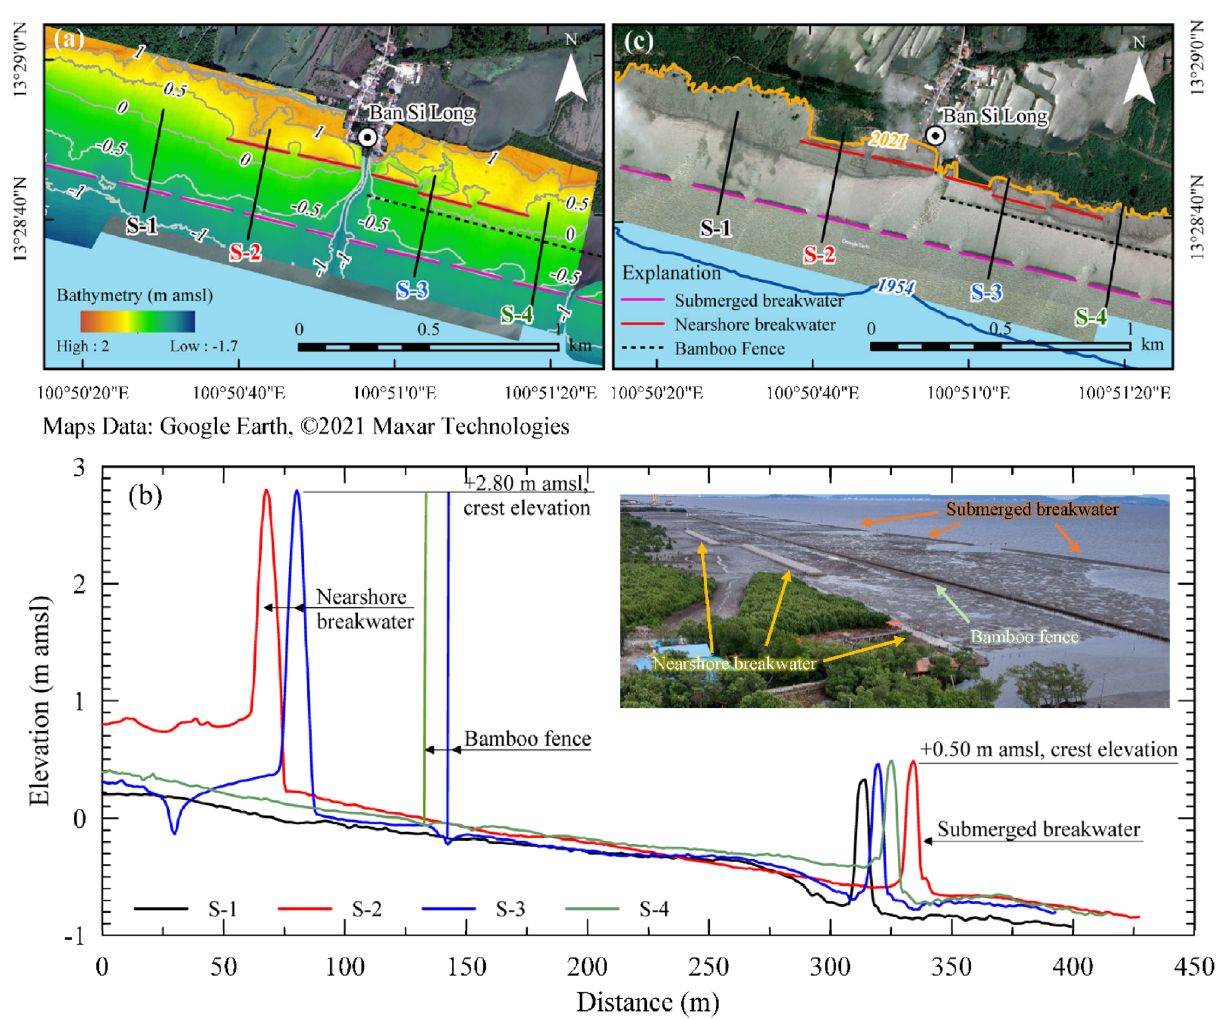
Figure 3. ( a ) LiDAR observation digital terrain model generated from the LiDAR point cloud at Ban Si Long. ( b ) Cross-section profiles of the shore and seabed and coastal protection structures location at Ban Si Long. The top-right photo shows the alignment of the structures and seafloor east of Ban Si Long. ( c ) The coastal protection structures were installed in the eroded area (between shorelines in 1954–2021). The satellite images of a and c were downloaded from Google Earth Pro (©2021 Maxar Technologies, https:// www. google. com/ earth), and the maps were created using ArcMap software version 10.6 ( © ESRI, https:// deskt op. arcgis. com). The photograph was taken by